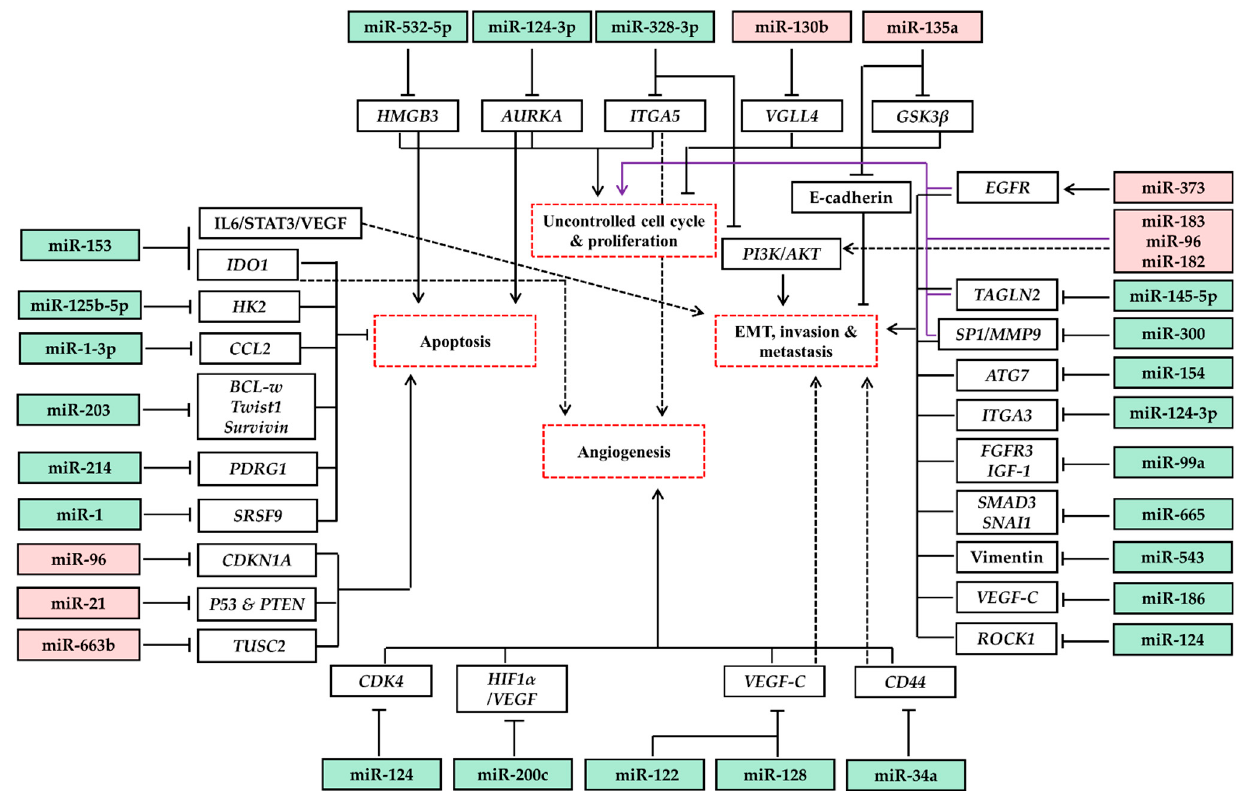
Figure 2. miRNAs up-regulated (red-colored) and down-regulated (green-colored) in urinary bladder cancer and their target genes. EMT: Epithelial-mesenchymal transition, EGFR: epidermal growth factor receptor, TAGLN2: Transgelin-2, MMP: matrix metaloprotenas, ATG7: Autophagy Related 7, ITGA: Integrin Subunit Alpha, FGFR: fibroblast growth factor receptor, IGF-1: insulin growth factor-1, SNAI1: Snail Family Transcriptional Repressor 1, VEGF: vascular endothelial growth factor, ROCK1: Rho Associated Coiled-Coil Containing Protein Kinase 1, HIF1A: Hypoxia-Inducible Factor 1 Subunit Alpha, CDK: cyclin-dependent kinase, STAT3: Signal Transducer And Activator Of Transcription 3, IDO: indoleamine 2,3-dioxygenase, HK2: hexokinase 2, CCL2: C-C Motif Chemokine Ligand 2 TWIST1: twist Family BHLH Transcription Factor 1, PDRG1: P53 And DNA Damage Regulated 1, SRSF9: serine/arginine-rich splicing factor 9, PTEN: phosphatase and tensin homolog, CDKN1A: Cyclin-Dependent Kinase Inhibitor 1A, TUSC2: Tumor Suppressor 2, Mitochondrial Calcium Regulator.